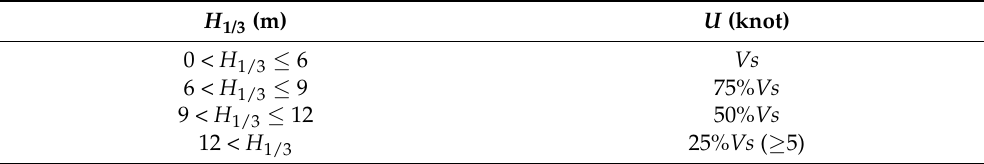
Table 3. The calculation speed at different significant wave